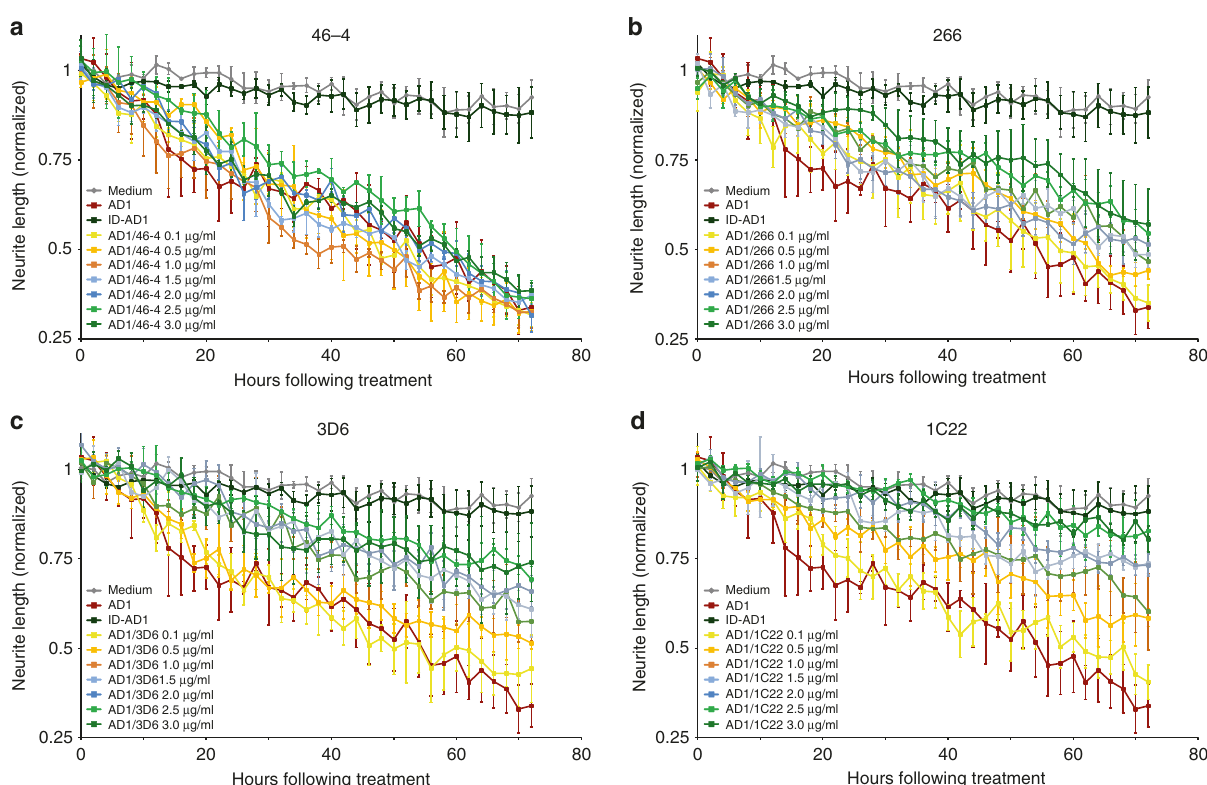
Fig. 6 Anti-A β antibodies dose-dependently attenuate the neuritotoxic effects of AD brain extracts. To determine whether anti-A β antibodies could protect against the neuritotoxicity induced by A β -containing AD brain extracts iNs were treated with AD1 extract at a dilution of 1:4 in the presence or absence of increasing amounts of antibody. Graphs show time-course measurements of NeuroTrack-de fi ned neurite length of iNs treated ± AD1 extract and a 46-4, b 266, c 3D6, and d 1C22. Each data point is the average of 3